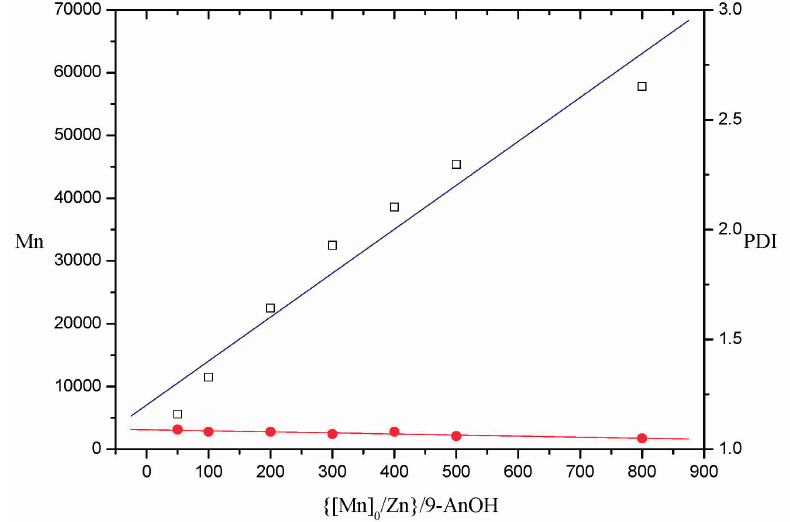
Figure 7. Polymerization of L -lactide catalyzed by 7 in toluene at 80 °C (PDI = Mn/Mw in Table